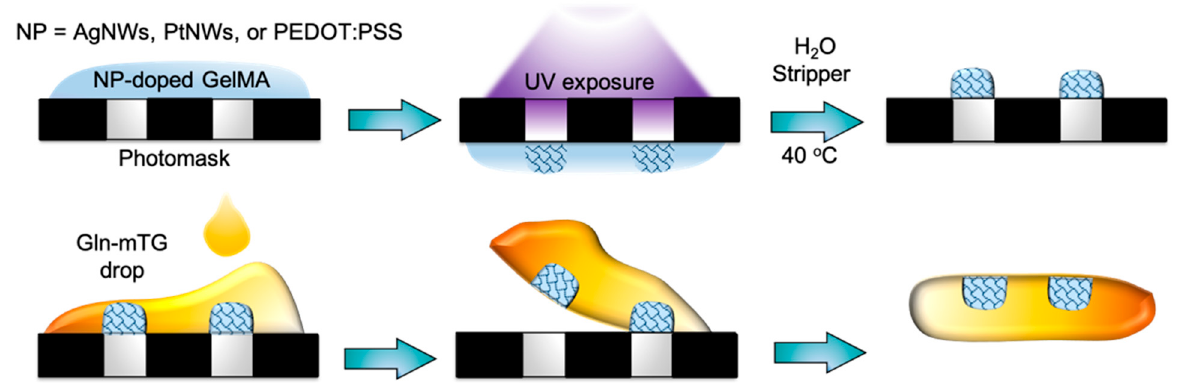
Figure 1. The fabrication process flow of hydrogel-based